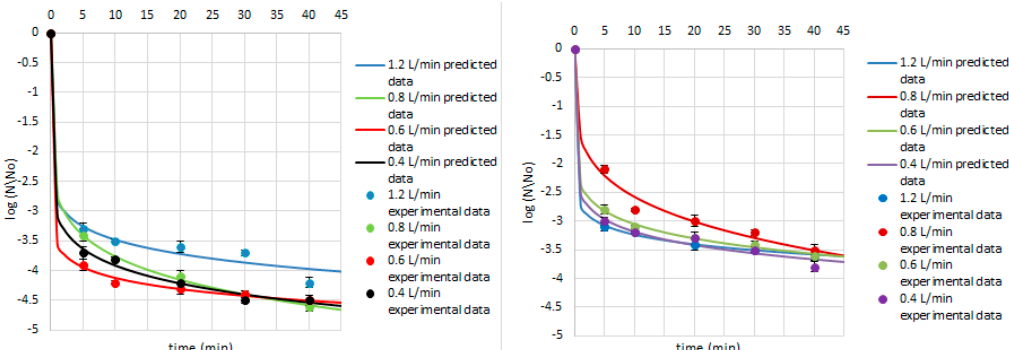
Figure 8. Survival of P. fluorescens on the cardamom seed ( left ) and juniper berry ( right ) matrix treated with ozone doses stimulated with flow rate of 1.2, 0.8, 0.6, and 0.4 L/min after 5, 10, 20, 30, and 40 min. Solid line: fit of the Weibull model (egn 1), dotted line: bacterial log counts.